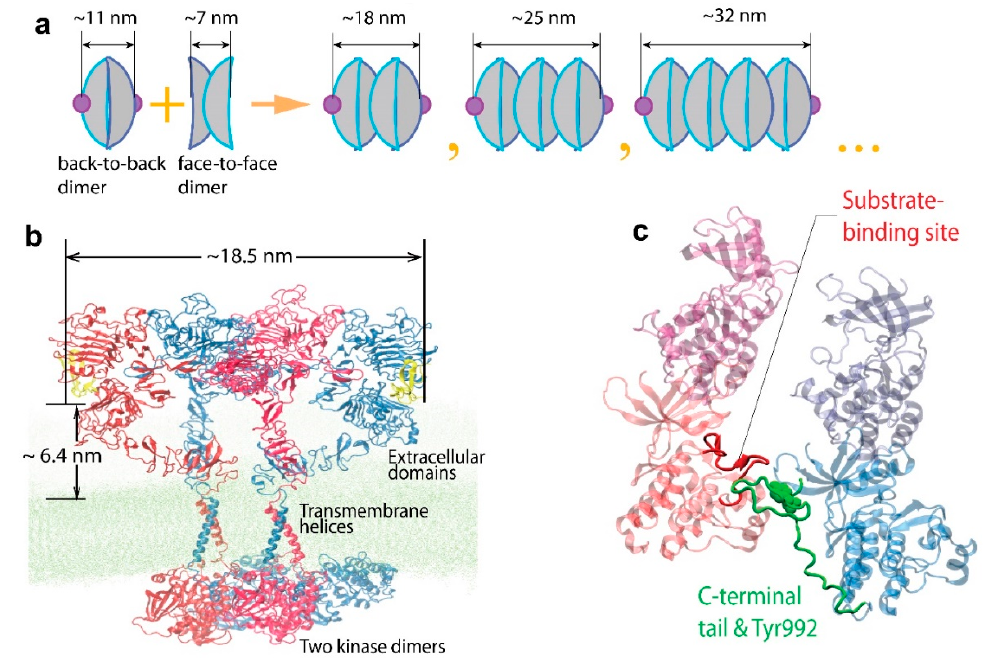
Figure 10. Model for EGFR oligomerization (figure adapted from Needham et al. (2016) [39]). ( a ) Illustration of a proposed oligomerization scheme for the EGFR extracellular domain, which depends on repeating back-to-back and face-to-face interactions of the receptor. ( b ) A complete model of an EGFR tetramer structure, which was formed by the dimerization through the face-to-face interaction of active dimers, showing the predicted separation between the N-termini of the two EGF ligands and the average EGF-membrane distance. ( c ) The arrangement of the two intracellular active kinase dimers in the tetramer model. The phosphorylation site Tyr992 (green) of one receptor is positioned close to the active site of a kinase domain (red) in the neighboring